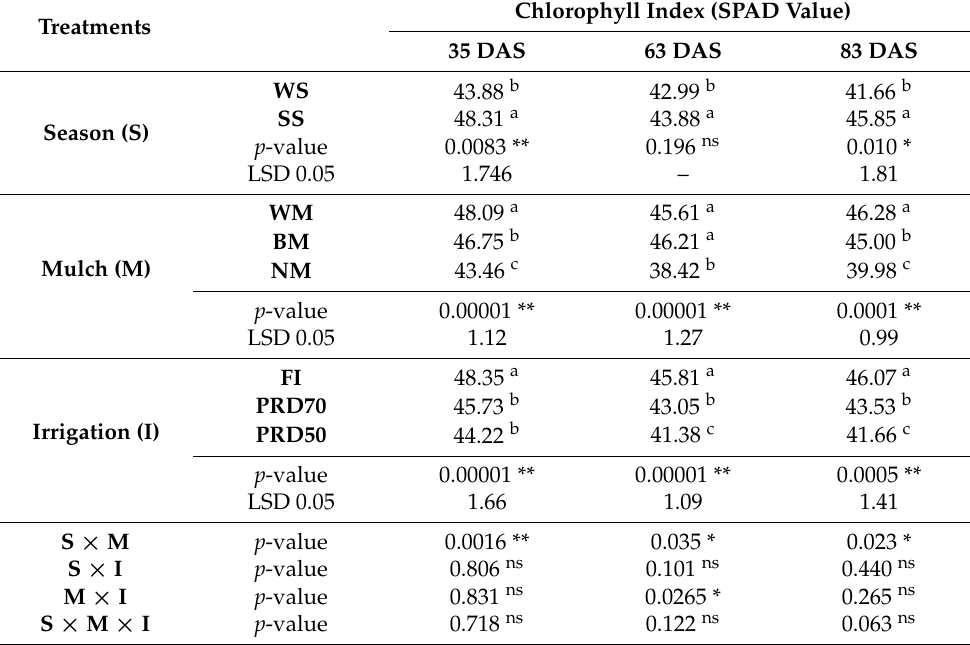
Table 3. Analysis of variance of the chlorophyll index (SPAD value) at the development stage (35 DAS), mid stage (63 DAS), and late stage (83 DAS) of squash growth during winter (WS) and spring (SS) growing seasons. Chlorophyll Index (SPAD Value) Treatments 35 DAS